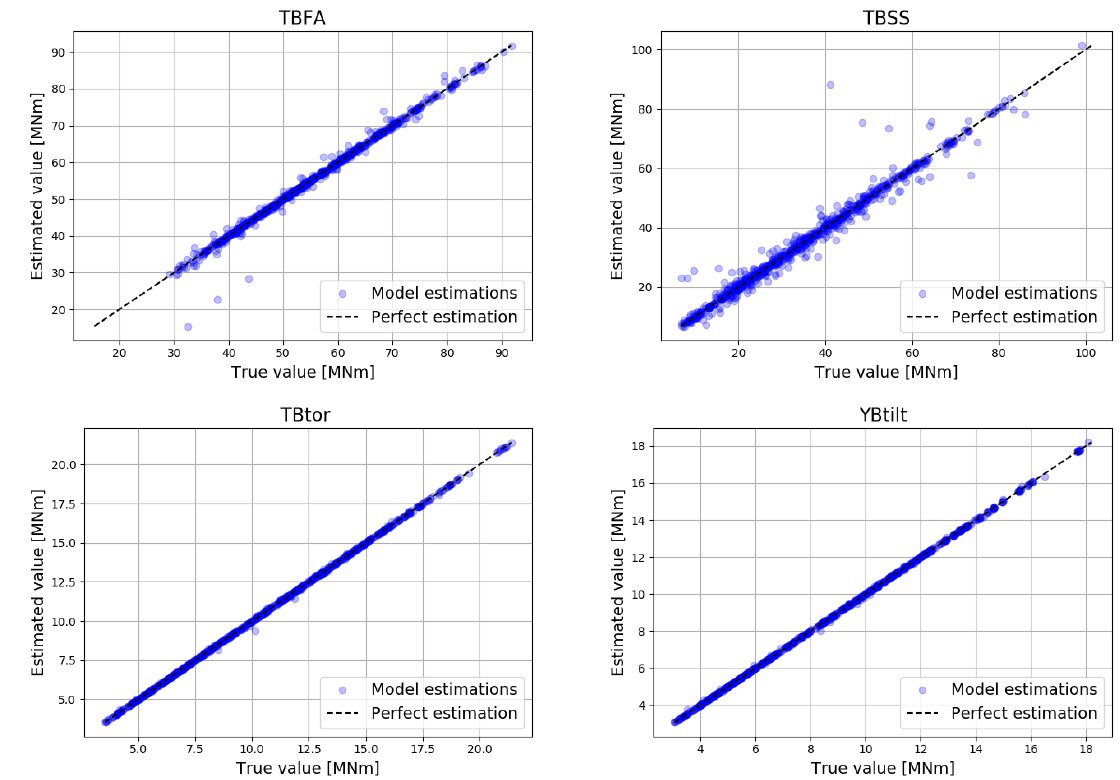
Figure 5. TBFA, TBSS, TBtor and YBtilt estimated and observed values for GPR method.